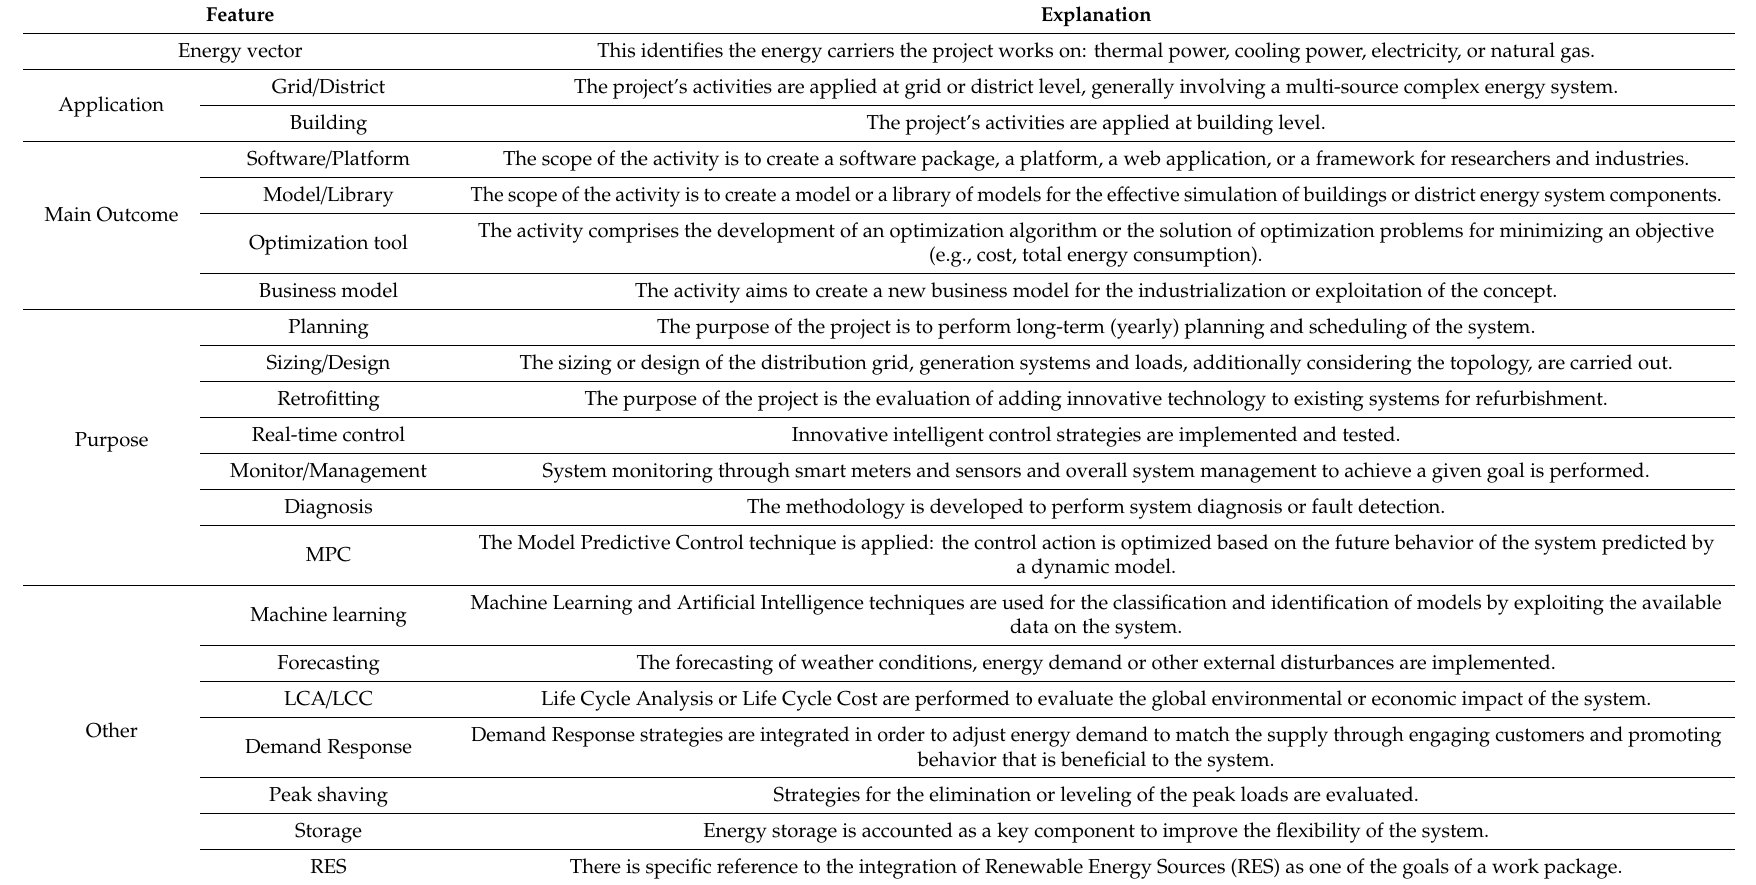
Table 1. Features for the selection of the research and innovation projects that involve smart energy